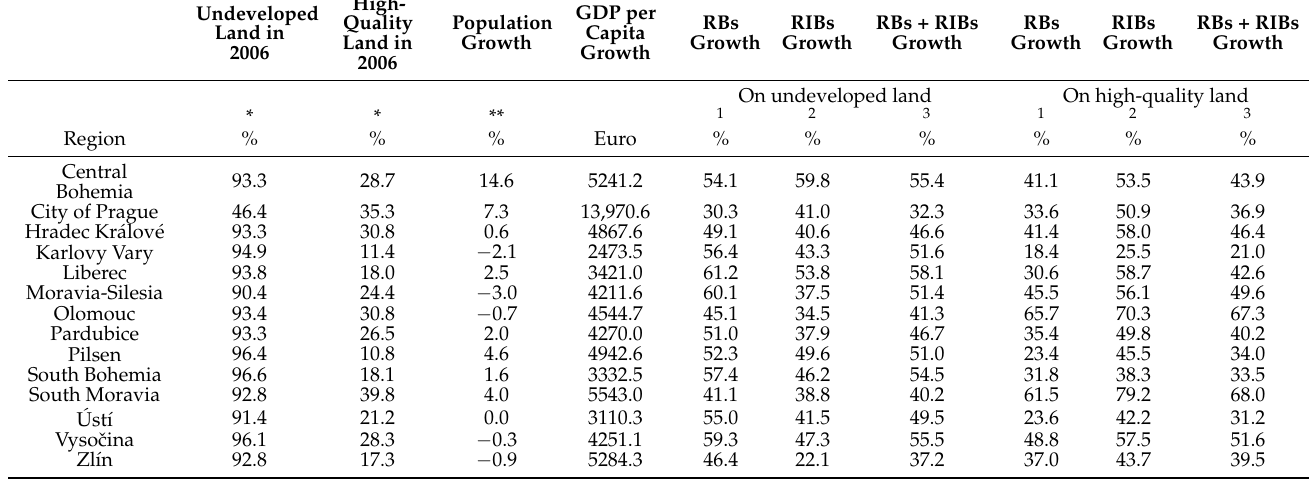
Table 1. Population growths, GDP per capita growths, and residential (RBs) and commercial (RIBs) buildings’ growth on undeveloped land and on high-quality land in the Czech Republic between 2006 and